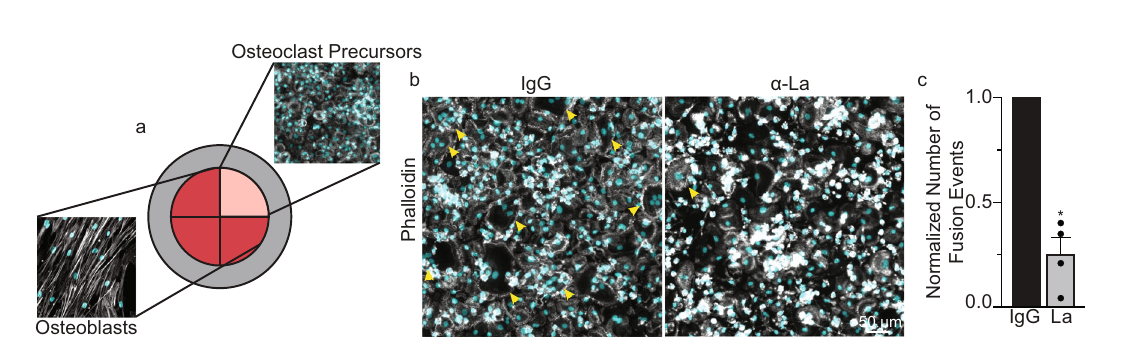
Fig. 7 | Osteoclast formation in human osteoblast/osteoclast precursor co- culturedependsonLaprotein.a Schematicofthemulti-wellcon fi gurationofthe human osteoblast/osteoclast co-culture system used. Multi-well dividers were removed following the M-CSF derivation of human monocytes, and osteoclast precursors and primary osteoblast media intermixed. (Grey=Phalloidin-Alexa488, Cyan=Hoechst). b Representative immuno fl uorescence images comparing